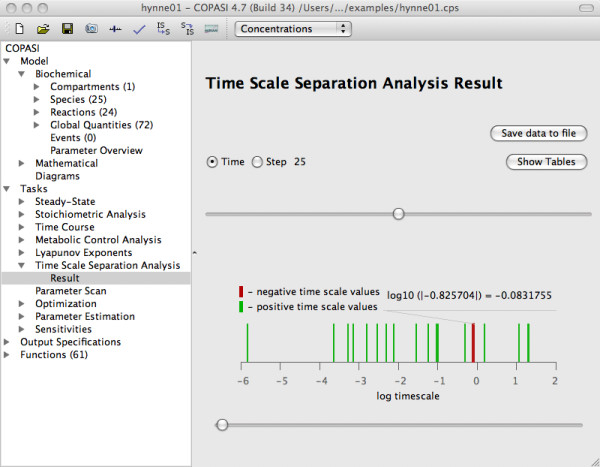
COPASI visualization of the time scale distribution. Full glycolysis model of Hynne et al. [16], [Glcx]0 = 14 mM, t = 25 min. The coincident bars on the graph correspond to equal time scales.